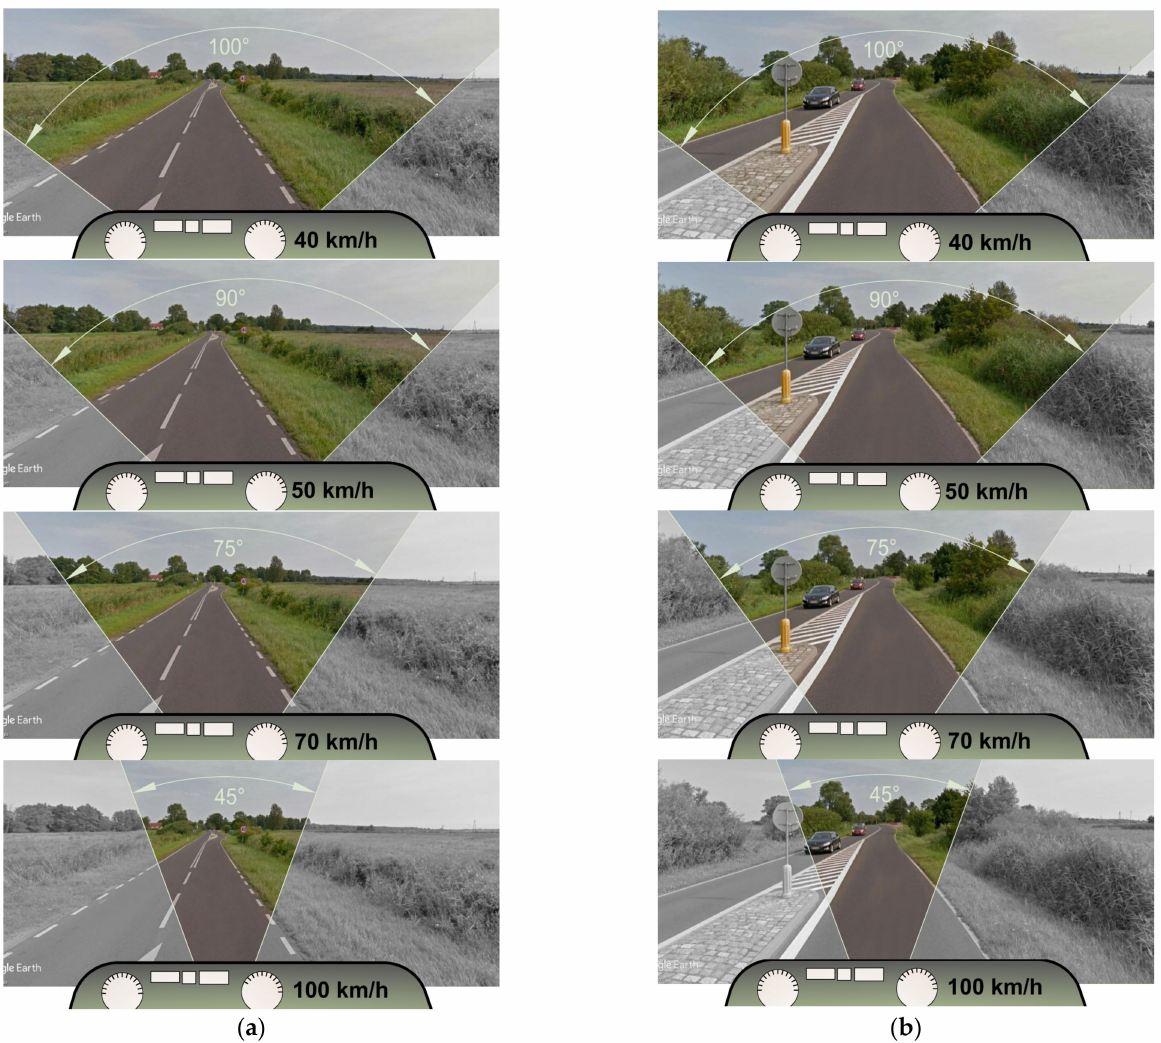
Figure 4. A visualisation of the central and peripheral vision areas on section No. 2, speed reduction ∆ v 85 = 14.3 km/h: ( a ) 100 m before chicane at v of: 40, 50, 70 and 100 km/h; ( b ) in the axis of the chicane at v of: 40, 50, 70 and 100 km/h. (Background photographs source: Google Earth